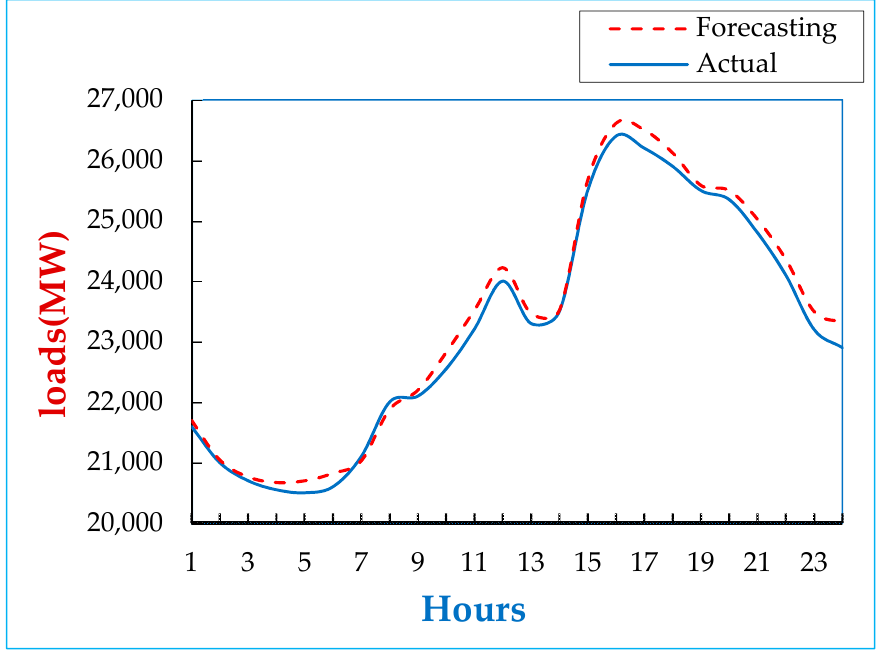
Figure 6. Load forecasting results for a week-long holiday (Saturday, 17 October 2020). Energies 2022 , 15 , 130